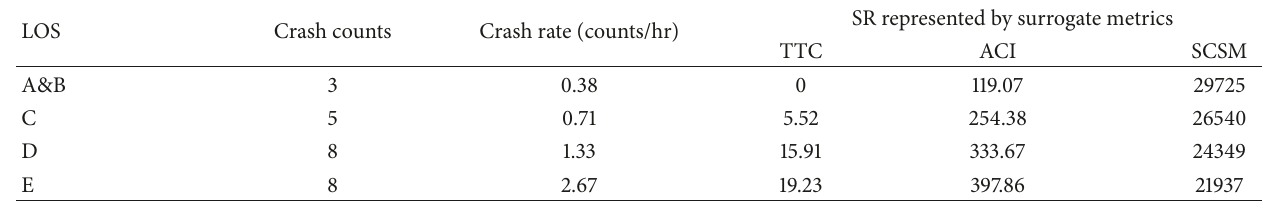
Table 5: Surrogate-based societal risk under four